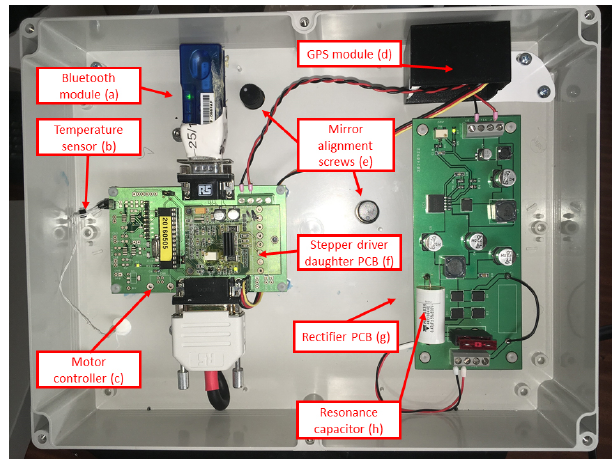
Figure 9. Elevation